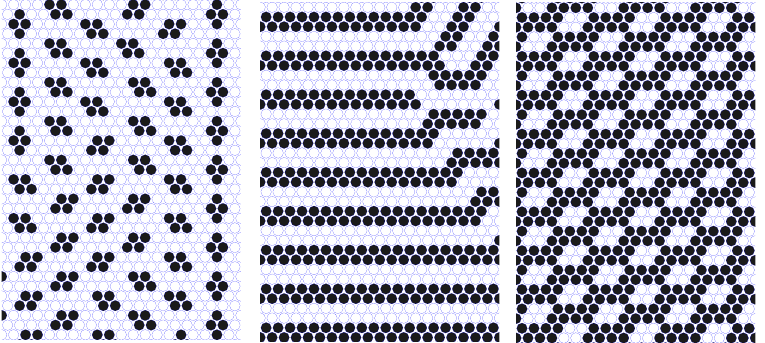
= − 20.0. ( Left , 1 = 0.0, µ ∗ = 6.0, and µ ∗ = 10.0, respectively. Black 2 2 2